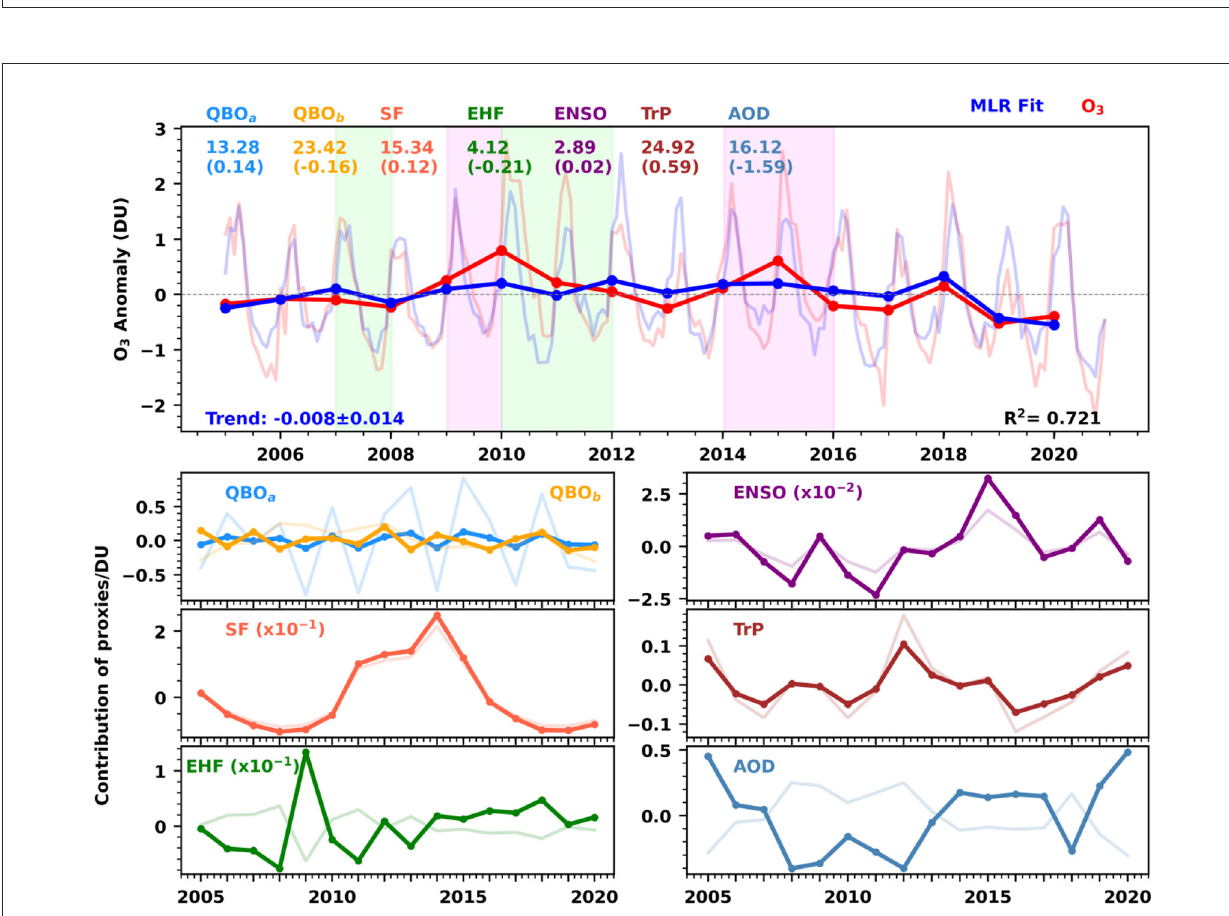
FIGURE5 (Top panel) Regression result based on the normalized TCO over TP for the period 2005–2020. Red line is the annually averaged anomaly of TCO and blue line represents the MLR fit. The numerical values indicate the relative importance of each contributor estimated using the Dominance Analysis. The values in brackets indicate the regression coefficient of each predictor. The light-colored red and blue lines indicate the monthly averaged time series of TCO and MLR fit, respectively. The lime-color shade represents strong La-Niña and light-magenta shade represents strong El Niño events during the period of study. (Bottom panels) The thick lines represent the contribution of each predictor for the period 2005–2020. The thin lines in the background represent the normalized distribution of predictors used. Here, QBO a and QBO b are the indices of Quasi-Biennial Oscillation indices 10 and 30 hPa, respectively, EHF is the Eddy Heat Flux at 100 hPa, SF is the Solar Flux, ENSO is the El-Niño Southern Oscillation Index, TrP is the tropopause Pressure and AOD is the Aerosol Optical